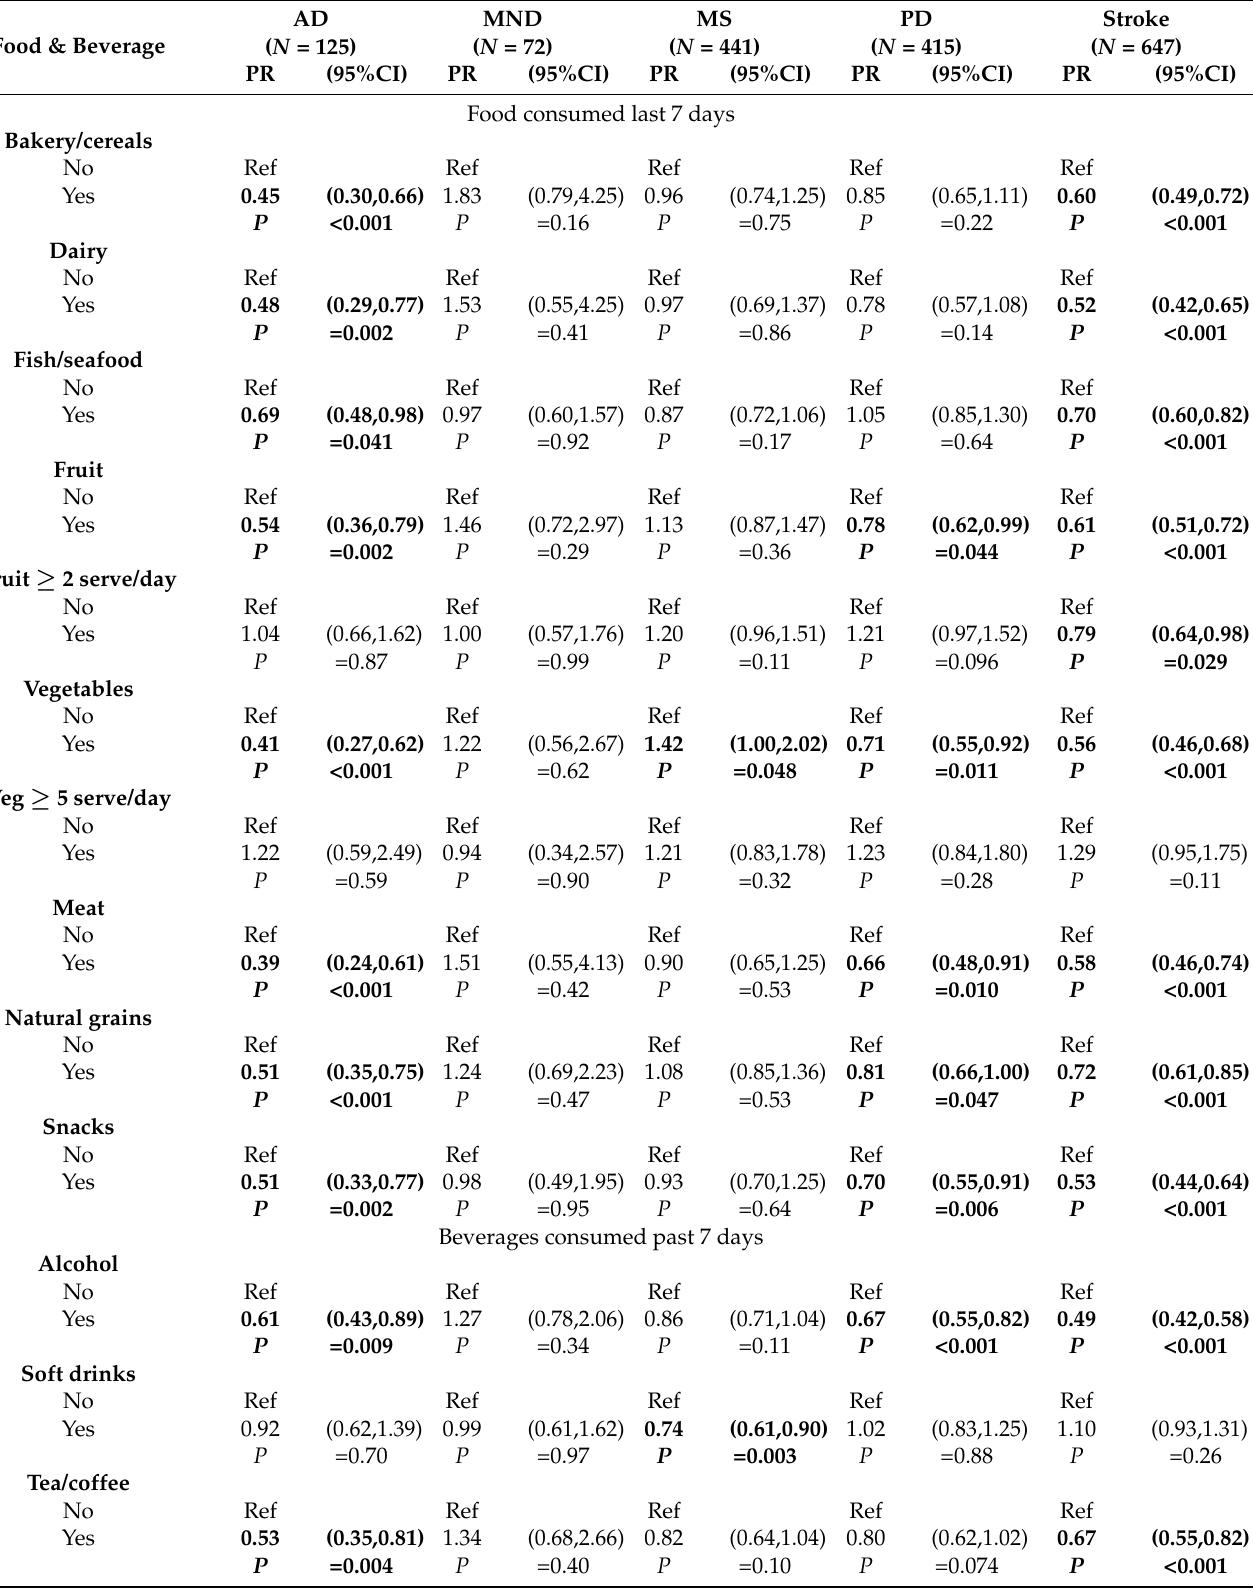
Table 5. Associations between food and beverage consumption and neurological disorders, referenced to the comparator population.